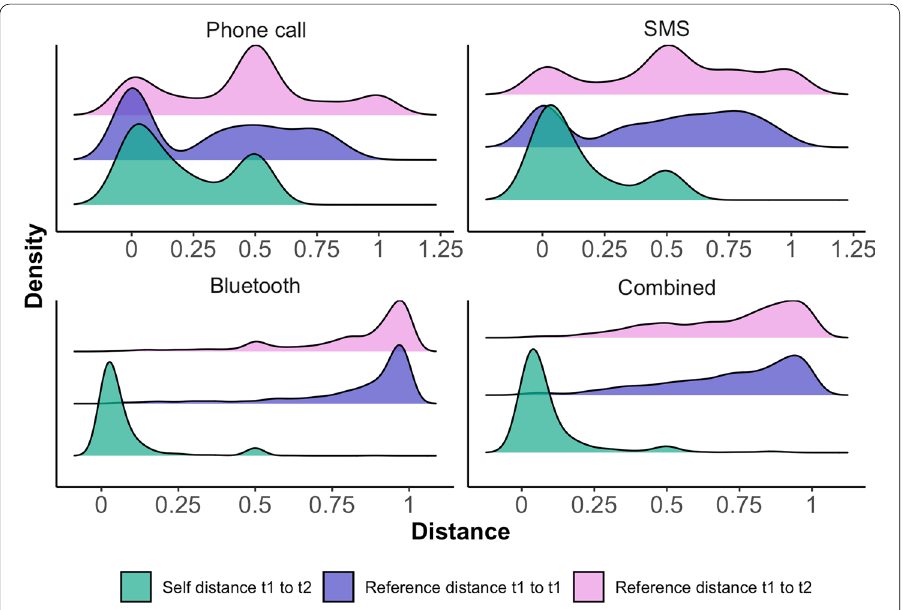
Fig. 4 The distributions of all self-distances d self and reference distances d ref 1 and d ref 2 , for all egos across different communication